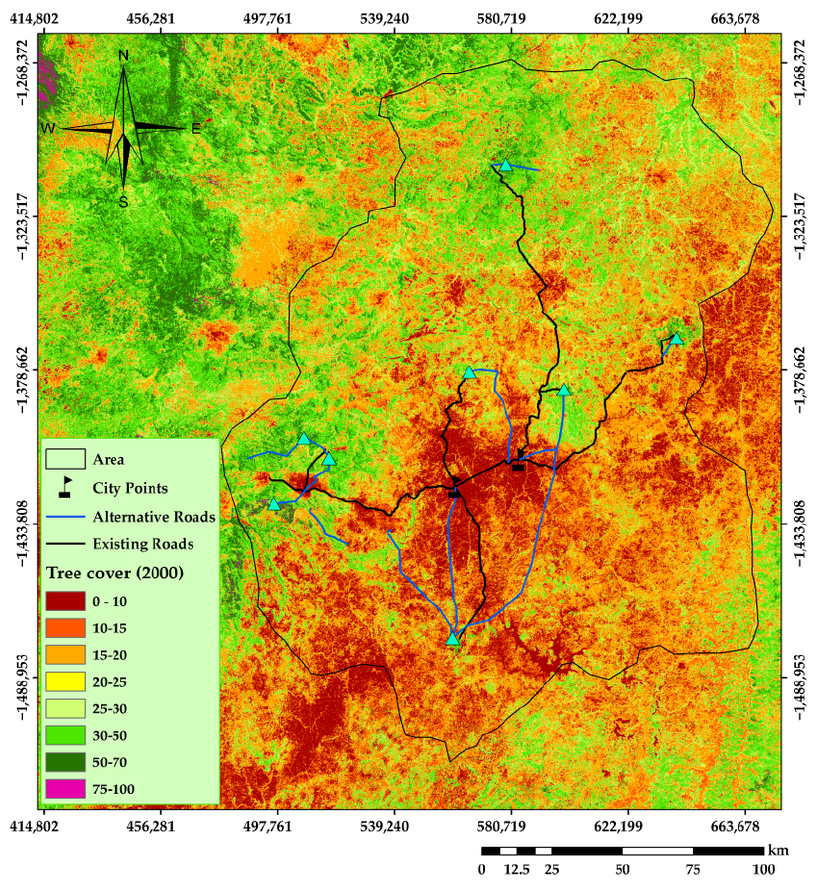
Figure 13. Tree cover in relation to new alternative roads.